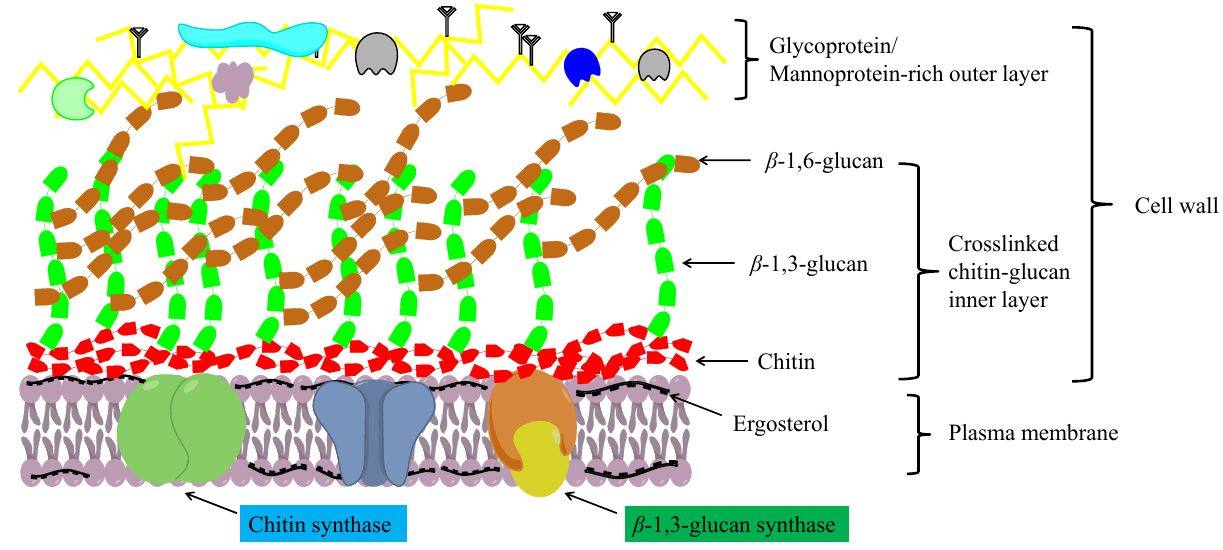
Figure 2. A schematic diagram showing the structure of the fungal cell wall.